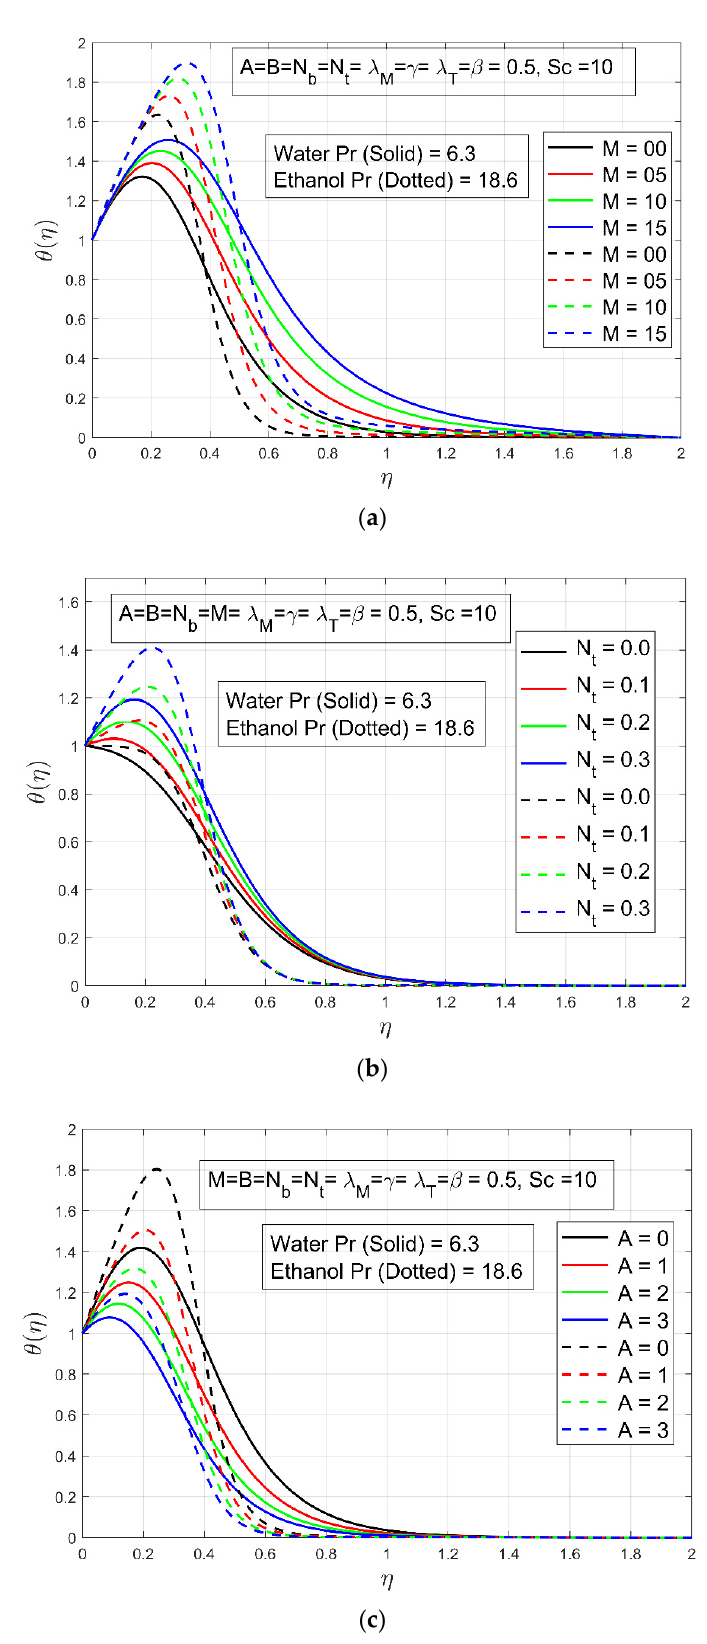
Figure 5. ( a ) The effect of M on temperature profile θ ( η ) ; ( b ) The effect of N t on temperature profile θ ( η ) ; ( c ) The effect of A on temperature profile θ ( η )